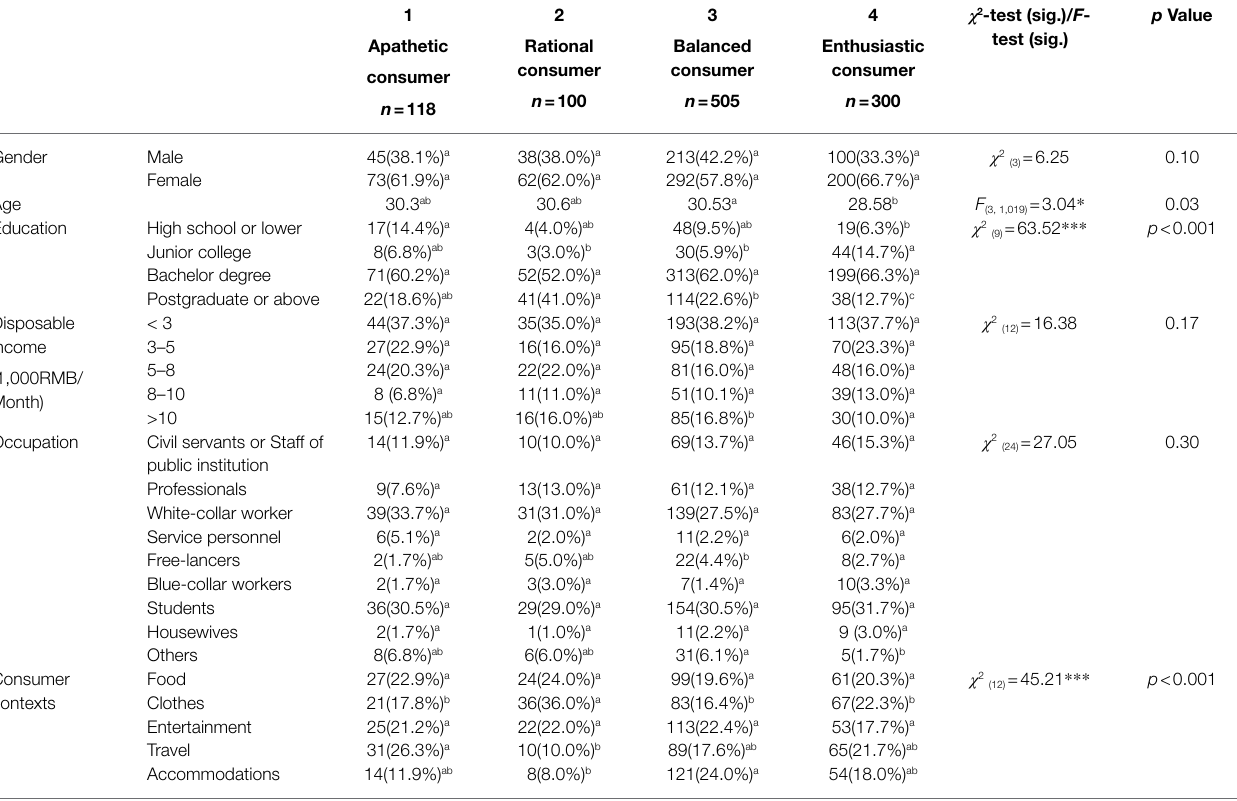
TABLE 6 | Differences in demographic variables across the profiles (Cross-tab with Pearson Chi-square).